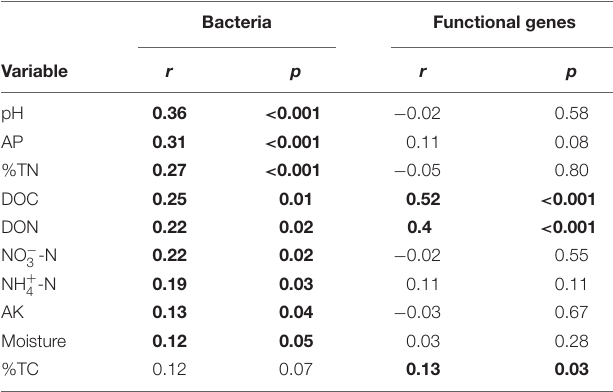
TABLE 2 | Mantel test results for the correlation between bacterial community composition and microbial functional gene composition and environmental variables along the elevational